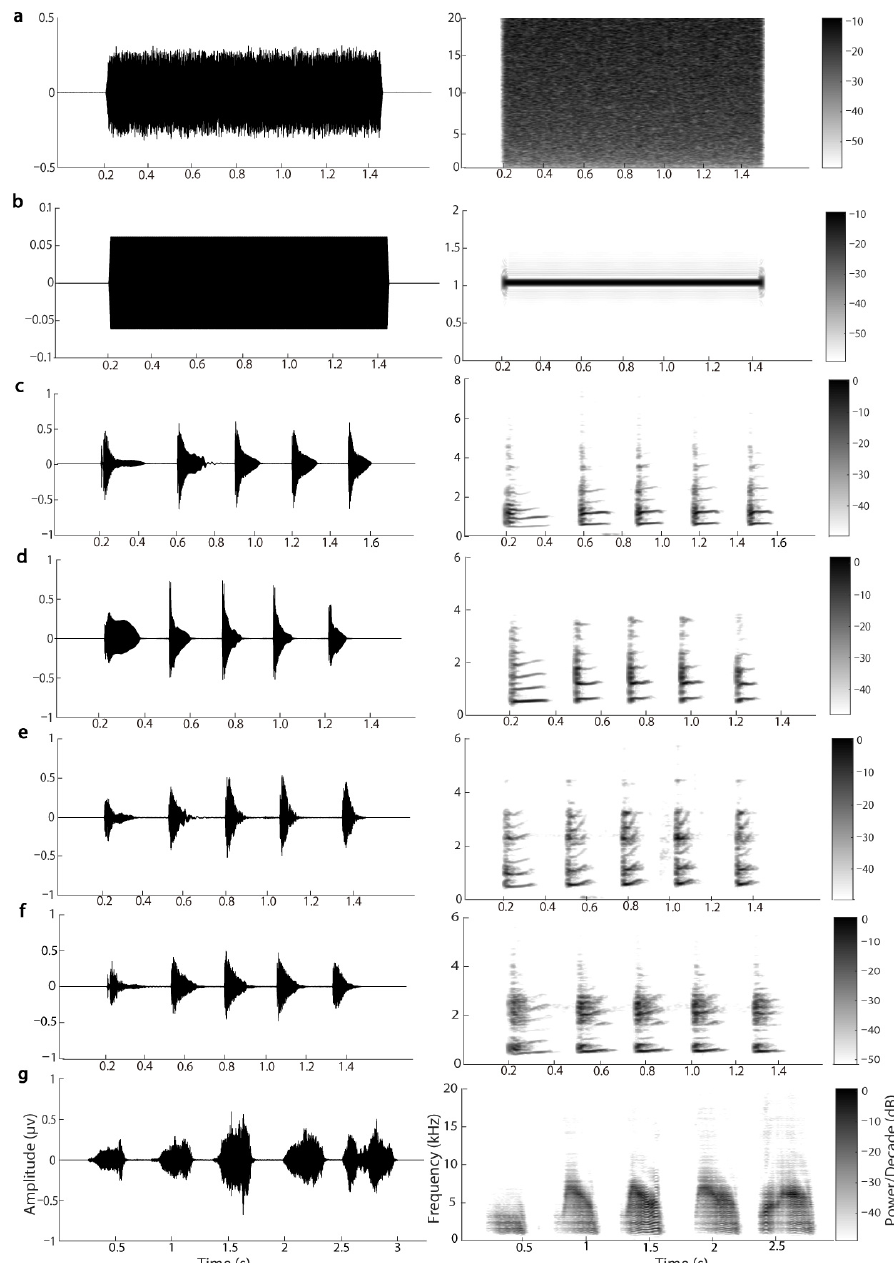
Figure 2. Waveforms and spectrograms of the seven acoustic stimuli: ( a ) white noise, ( b ) 1000 Hz pure tone, ( c – f ) four conspecific advertisement calls from different individuals, ( g ) screech call.